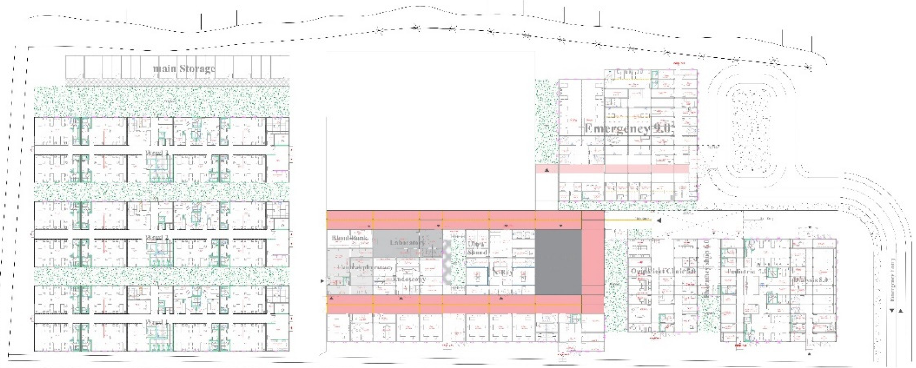
Figure 4. Photographic documentation of the relocatable hospital in Mosul.